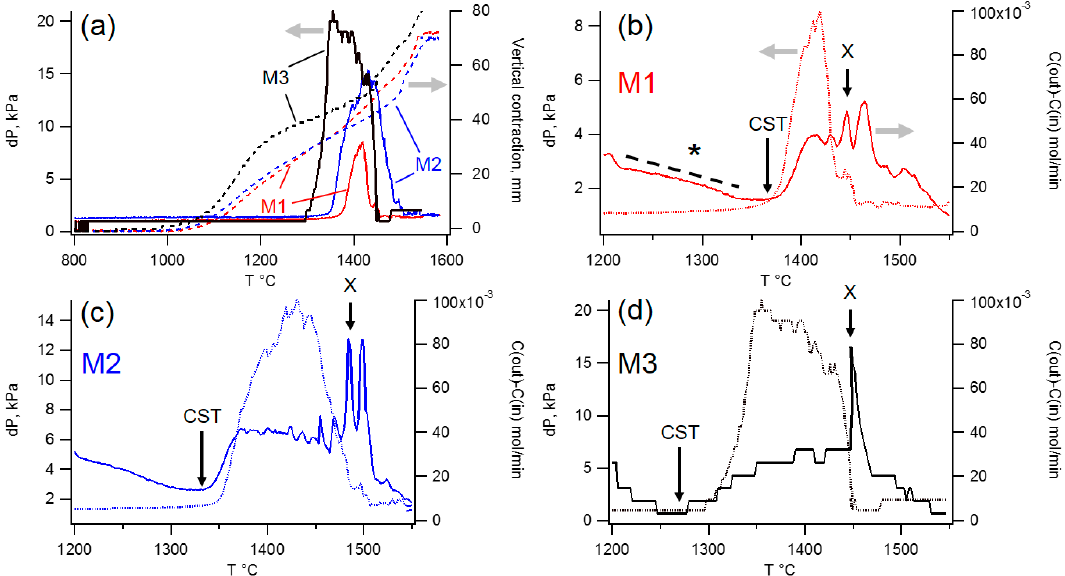
Figure 2. ( a ) Pressure drop (solid curves) and vertical bed contraction (dashed curves) against temperature for mixed burdens M1–M3; ( b – d ) per burden, calculated C(out)-C(in) based on off-gas and in-gas analyses, with dP curve for reference.